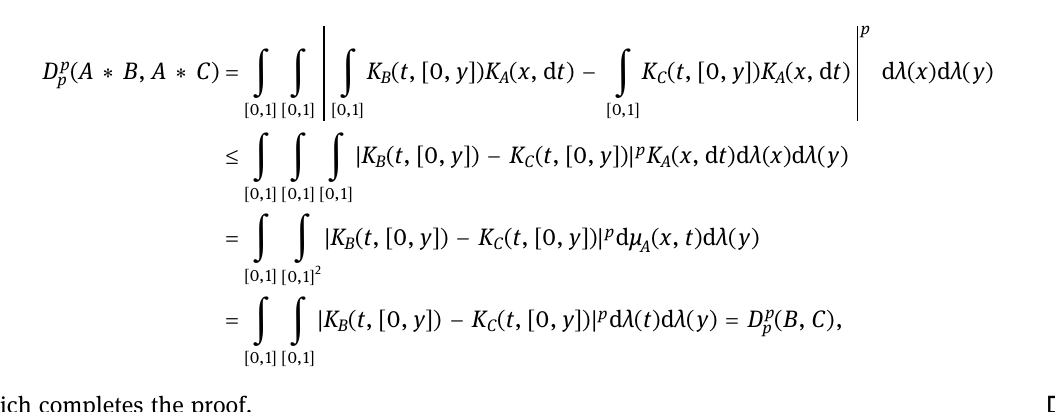
Figure 3: The support of the copulas μ ( magenta ) as considered in Example